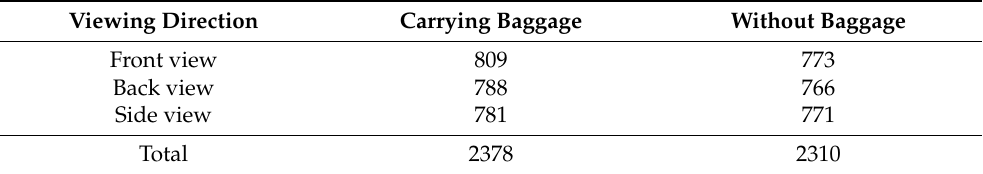
Table 3. ILIDS dataset distribution.